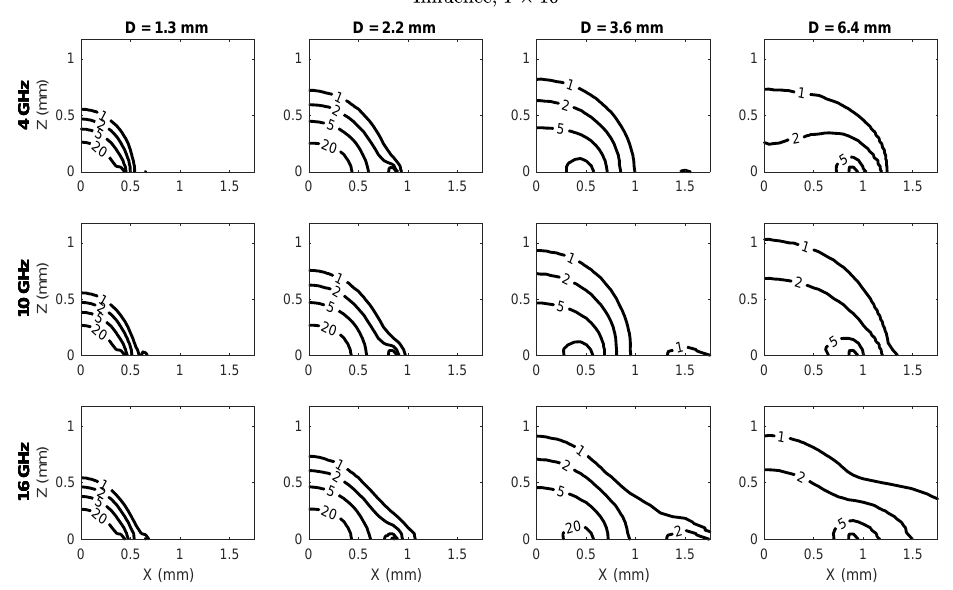
Figure 3. Influence in the xz -plane, where x = 0 coincides with the probe symmetry axis and z = 0 lies along the probe measurement plane. Influence peaked near the outer edge of the center conductor at z = 0 for all